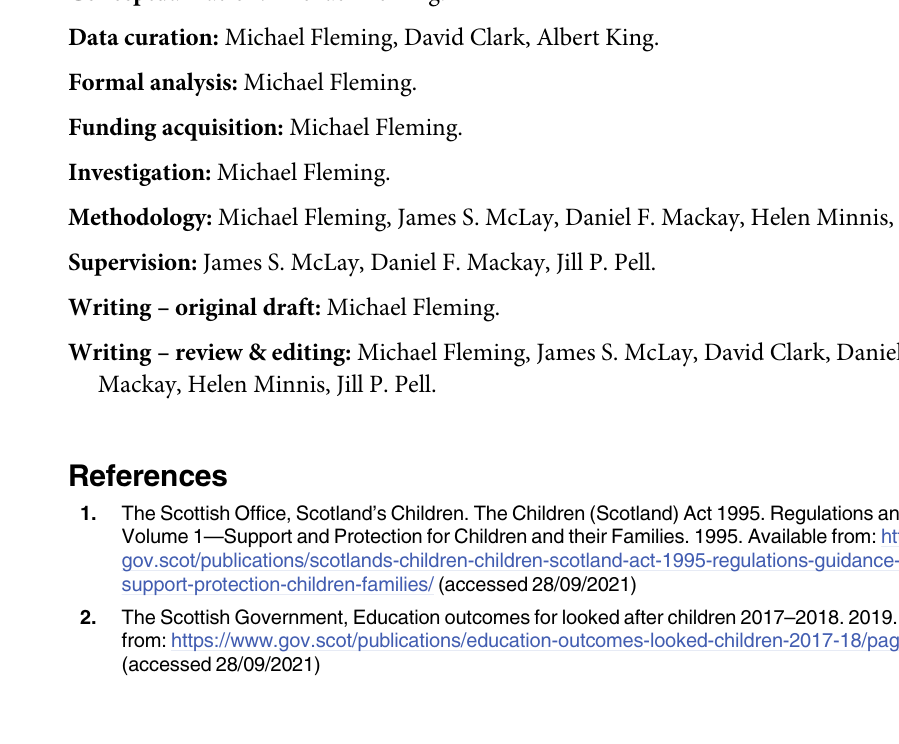
S1 Table. SEN categories. SEN, special educational need. S2 Table. Association between being looked after at school and educational and health out- comes after further adjustment for potential confounders. S3 Table. Type of placement and total number of years in care among 13,898 looked after children. S4 Table. Type of placement and educational outcomes among looked after children. S1 Fig. Linkage of education to health data. S2 Fig. Linkage flow diagram detailing number of pupils included and excluded at each stage of data